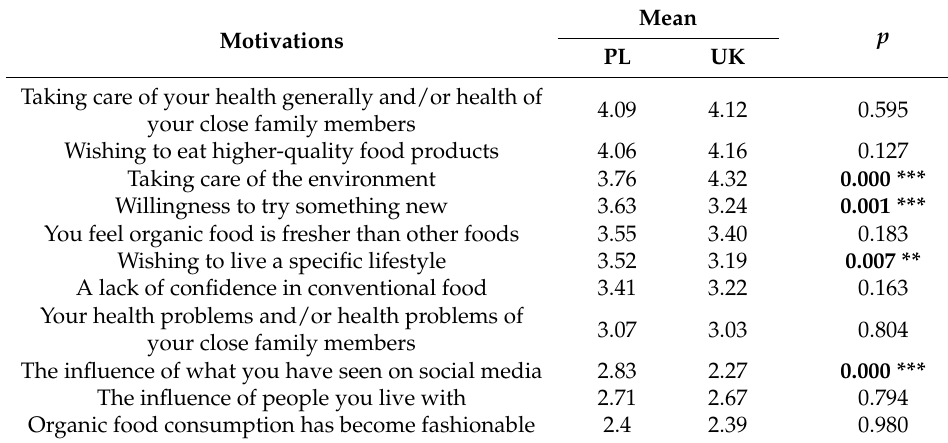
Table 5. The differences in motivations for purchasing organic products between respondents from PL and the